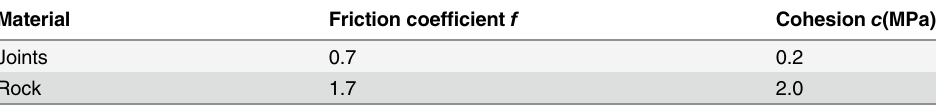
Table 1. The strength parameters of the joint surface and the rock bridge